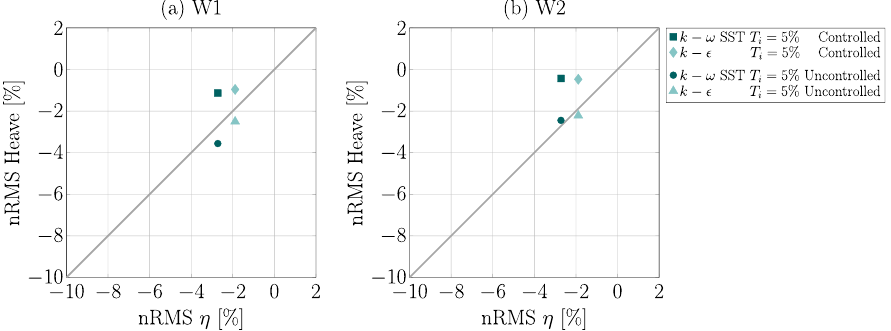
Figure 11. nRMSD of the heave displacement over the nRMSD of the free surface elevation for ( a ) W1 and ( b )